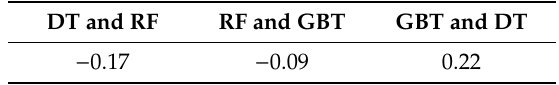
Table 7. Kendall rank correlation coe ffi cient for di ff erent scoring